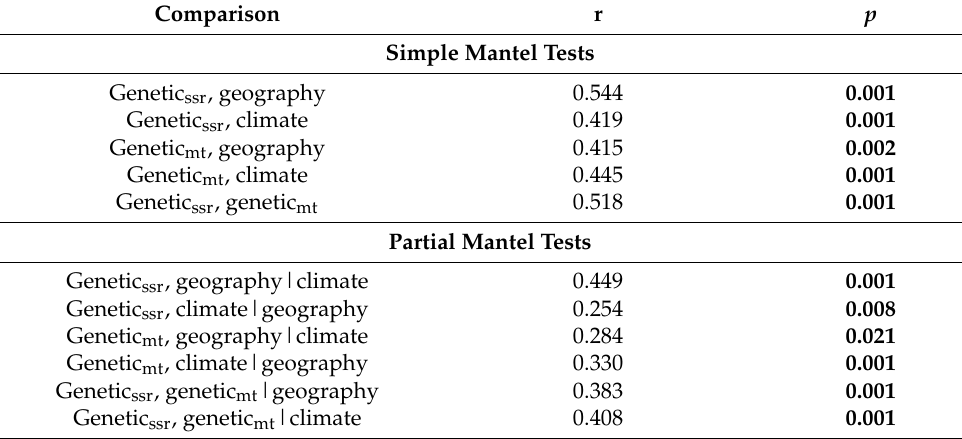
Figure 3. STRUCTURE analysis of Hipposideros larvatus nuclear microsatellite genotypes for K = 2 and 3 clusters. Black lines separate individuals of different populations. Population names are labeled under the figure, with their regional affiliations (mainland China and Hainan Island) above it. Table 2. Correlations between microsatellite (Genetic ssr ) and mitochondrial (Genetic mt ), climatic (from principal component analysis PCs 1–3) and geographic (km) differences among 18 populations of Hipposideros larvatus, tested with simple and partial Mantel tests. Boldface indicates significant p values ( p < 0.05) after multiple testing